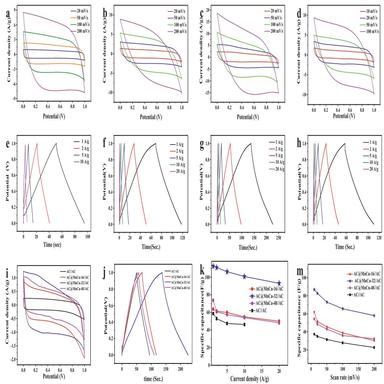
Electrochemical properties of four electrode materials in a two-electrode system: The CV curves of (a) AC//AC, (b) AC@MnCu-16//AC, (c) AC@MnCu-32//AC, (d) AC@MnCu-48//AC and GCD curves of (e) AC//AC, (f) AC@MnCu-16//AC, (g) AC@MnCu-32//AC, (h) AC@MnCu-48//AC, (i) CV curves of the four electrode materials at a scanning rate of 5 mV/s, (j) GCD curves at a current density of 1 A/g, and (k) curves of mass ratio capacitance changing with the current density; (m) the specific capacitance of four electrode materia